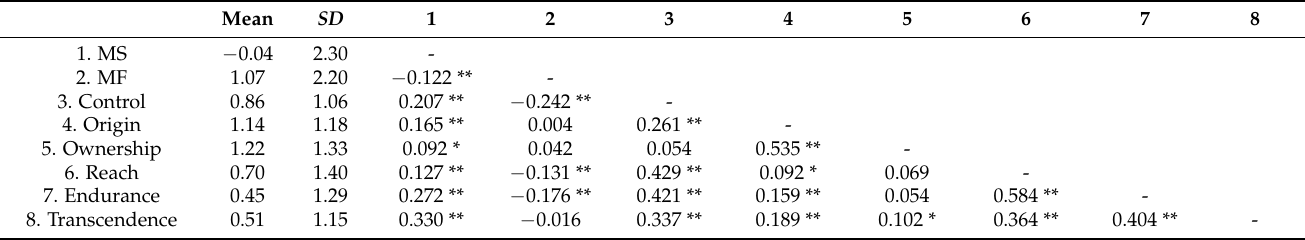
Table 4. Model Means of Rasch-calibrated measures, standard deviations, and correlations between each subscale and the achievement motivation